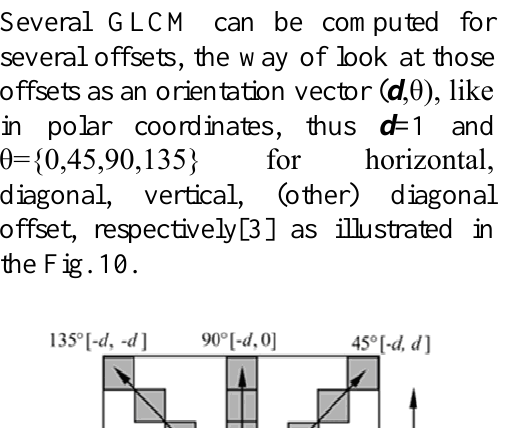
Fig.9: Graycomatrix creates a gray- level co-occurrence matrix (GLCM).